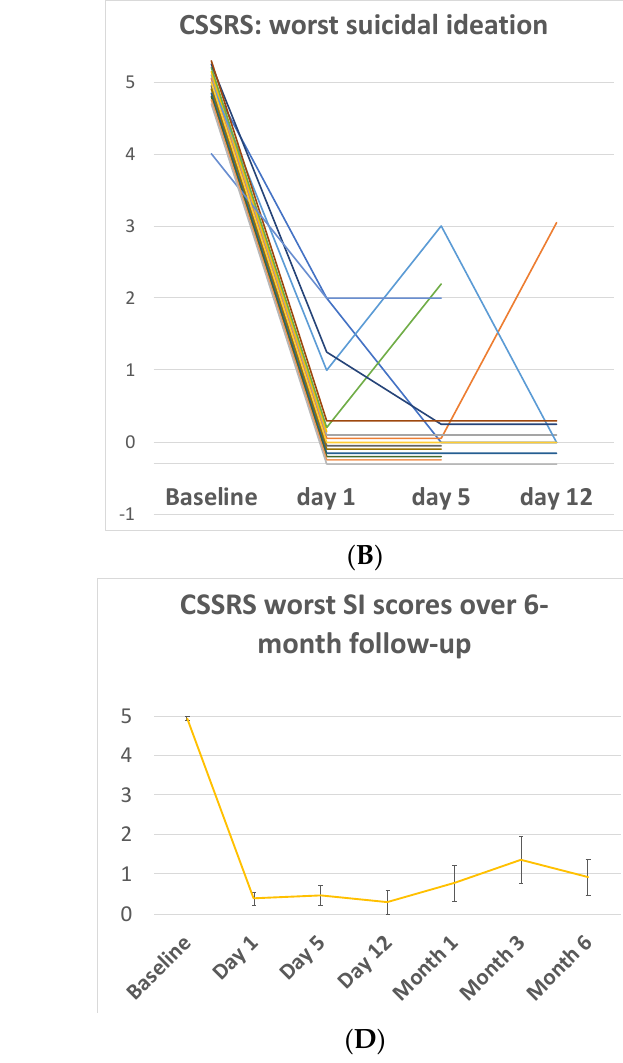
Figure 2. ( A ) Total depression severity scores measured by the Montgomery-Asberg Depression Rating Scale (MADRS) in each individual patient as a function of time during the first 12 days post-enrollment. ( B ) Worst suicidal ideation scores measured by the Columbia Suicide Severity Rating Scale (CSSRS) in each individual patient as a function of time during the first 12 days post-enrollment. ( C ) Group mean total depression scores from baseline to month 6. ( D ) Group mean worst suicide ideation scores from baseline to month 6.